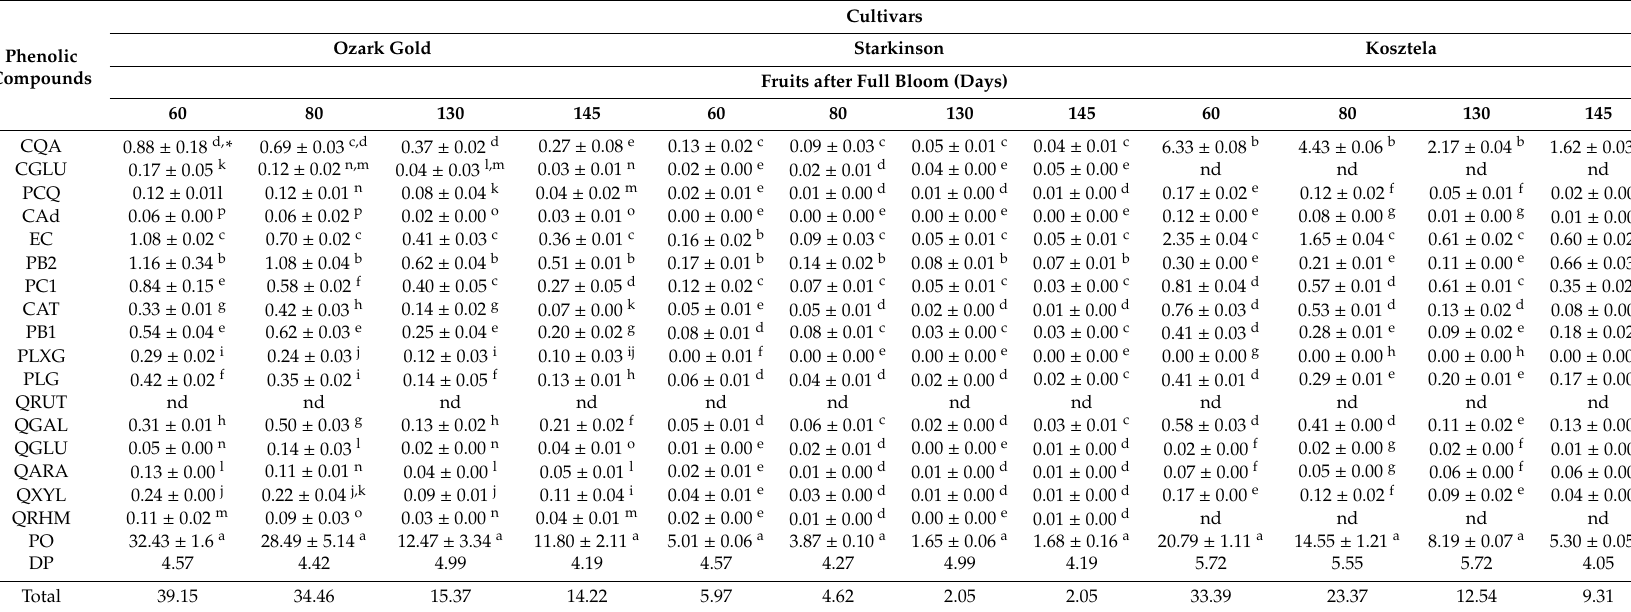
Table 2. Change of the polyphenol content (g kg − 1 dw) in the di ff erent apple cvs. during the developing and ripening of the